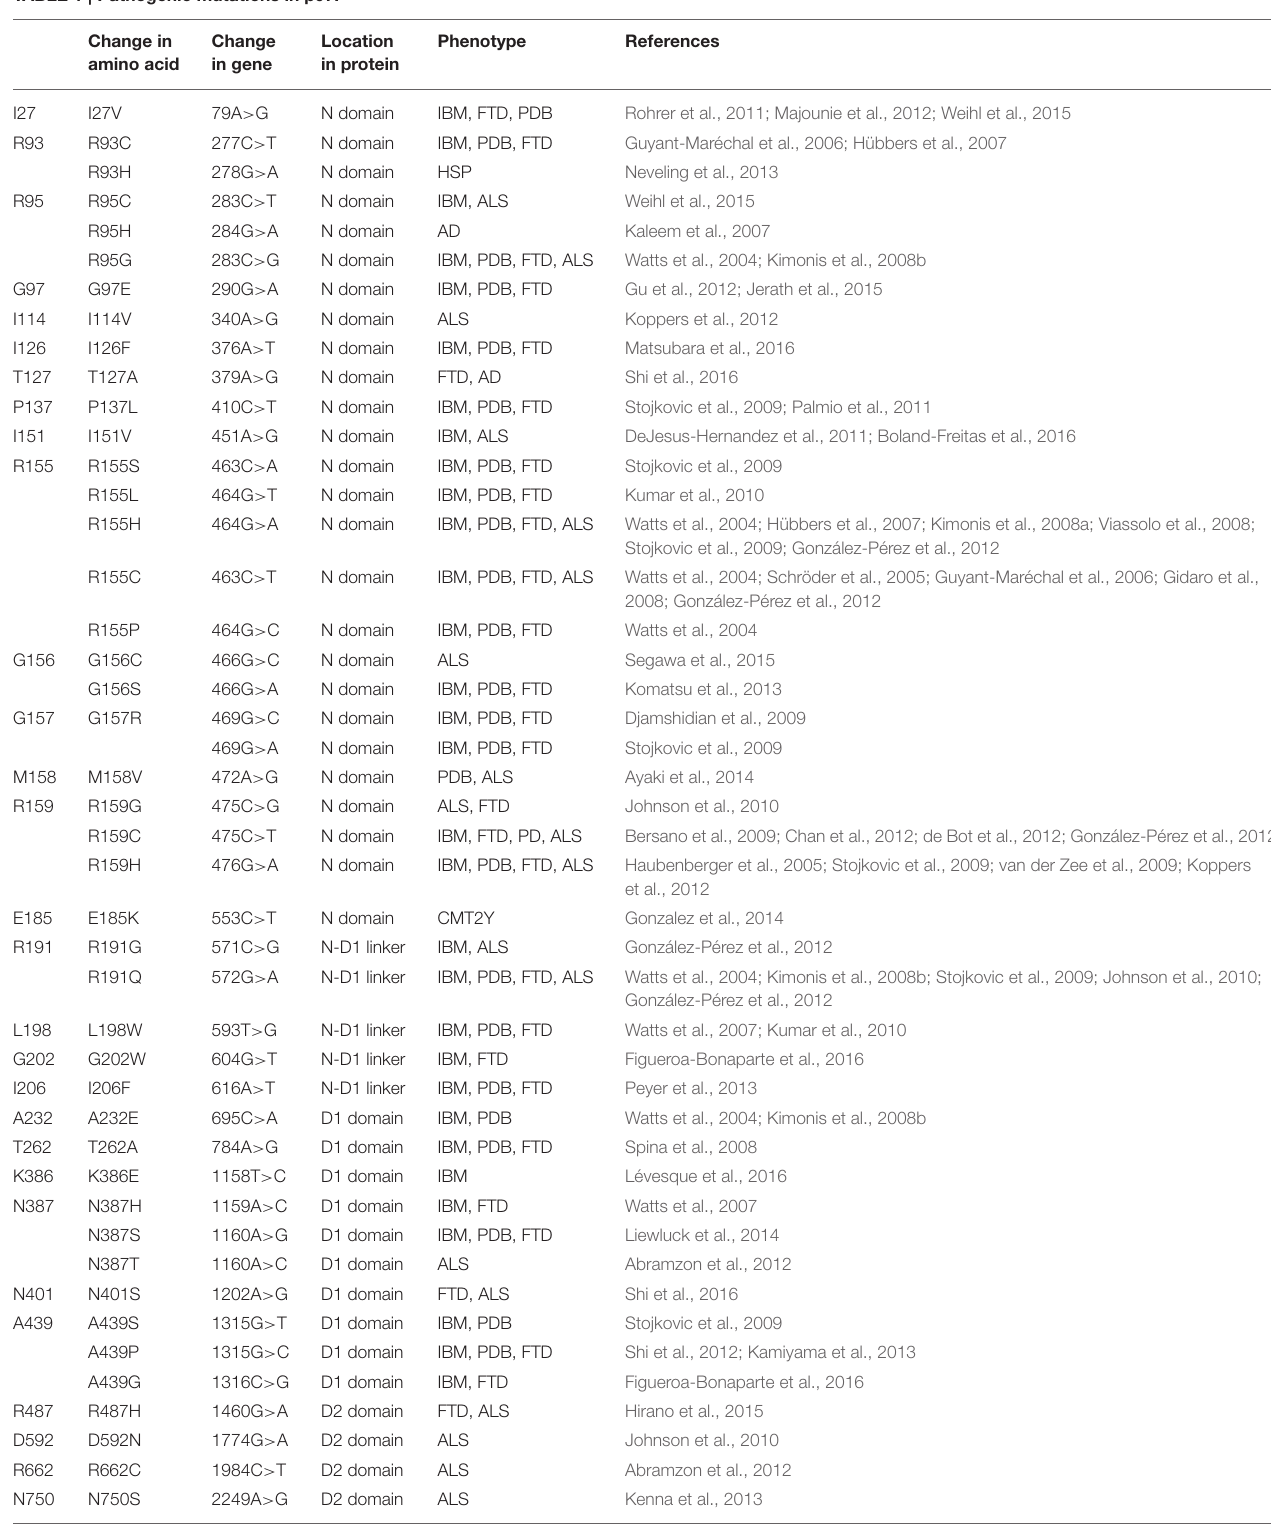
TABLE 1 | Pathogenic mutations in p97.